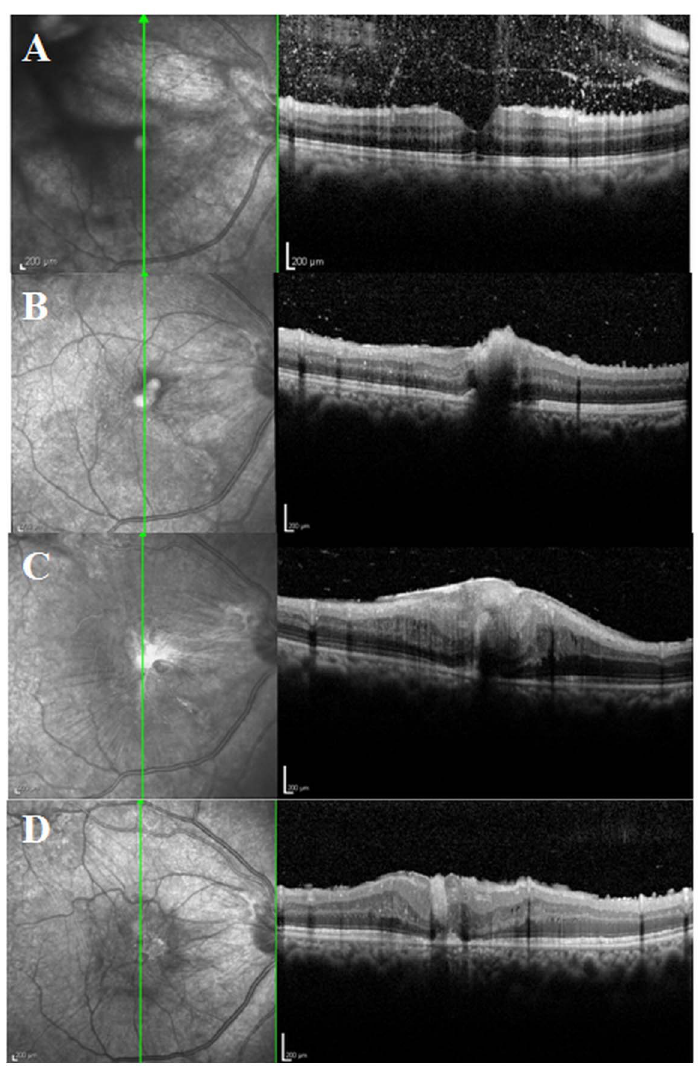
Figure 3. Spectral domain optical coherence tomography (SD-OCT) images showing progressive retinal damage by ocular toxocariasis granulomas. (A) Before discontinuous migration, a normal macular structure is visible, but scattered hyper-reflective dots indicate vitritis. (B) After discontinuous migration from the peripheral retina to the macula, a macular granuloma is observed in the inner retinal layers. (C) One month later, the inner retinal layers show severe distortion, a thick epiretinal membrane is present, and the granuloma extends to the outer retinal layers. (D) Three months after vitrectomy and epiretinal membrane removal, structural damage has not completely resolved. 39:13 in the patient and control groups, respectively, P = 0.92).